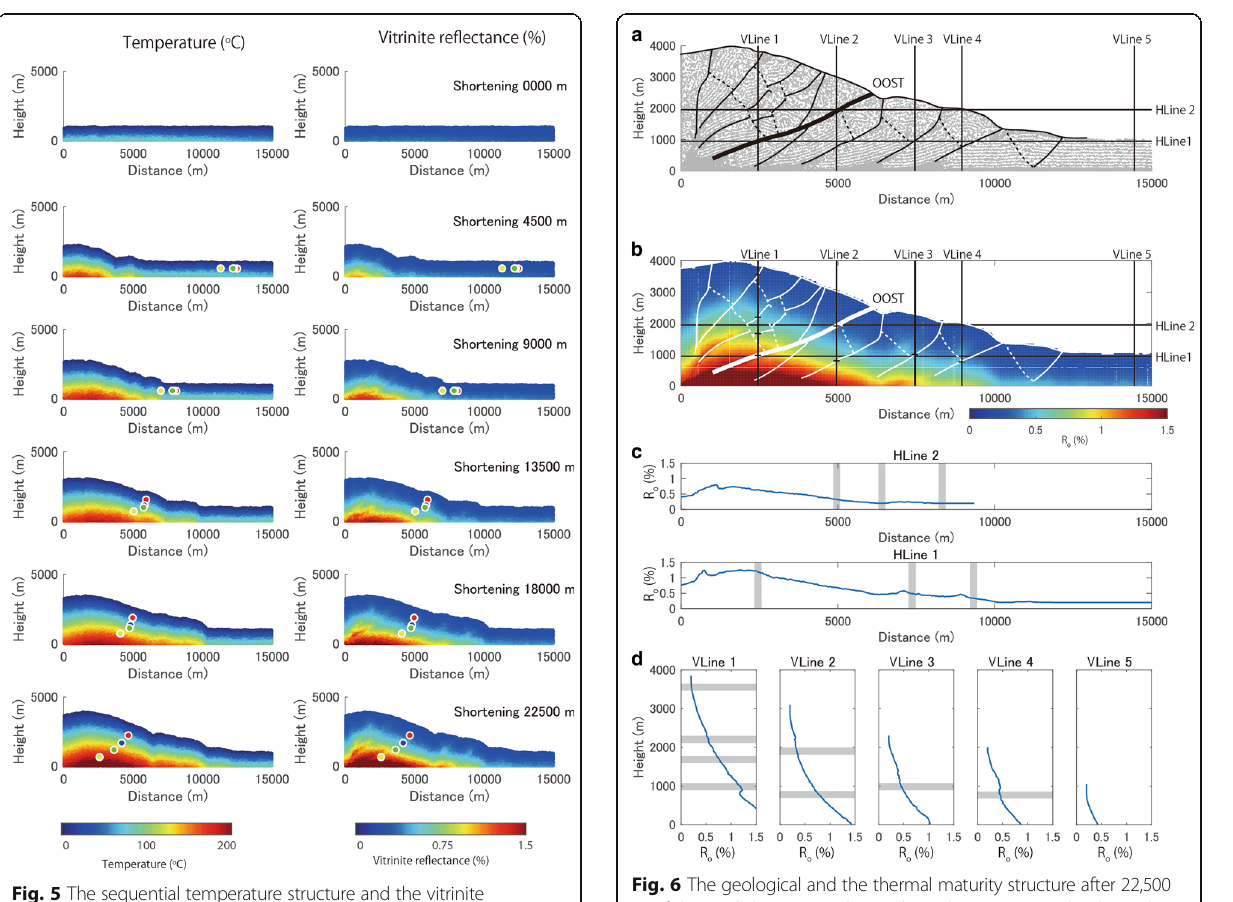
Fig. 5 The sequential temperature structure and the vitrinite reflectance structure after every 4500m of shortening from 0 to 22,500m of the total shortening. The colored particles with white edge on the simulation results are the target particles that are used for monitoring their depth, temperature, and vitrinite reflectance (Fig. 4)